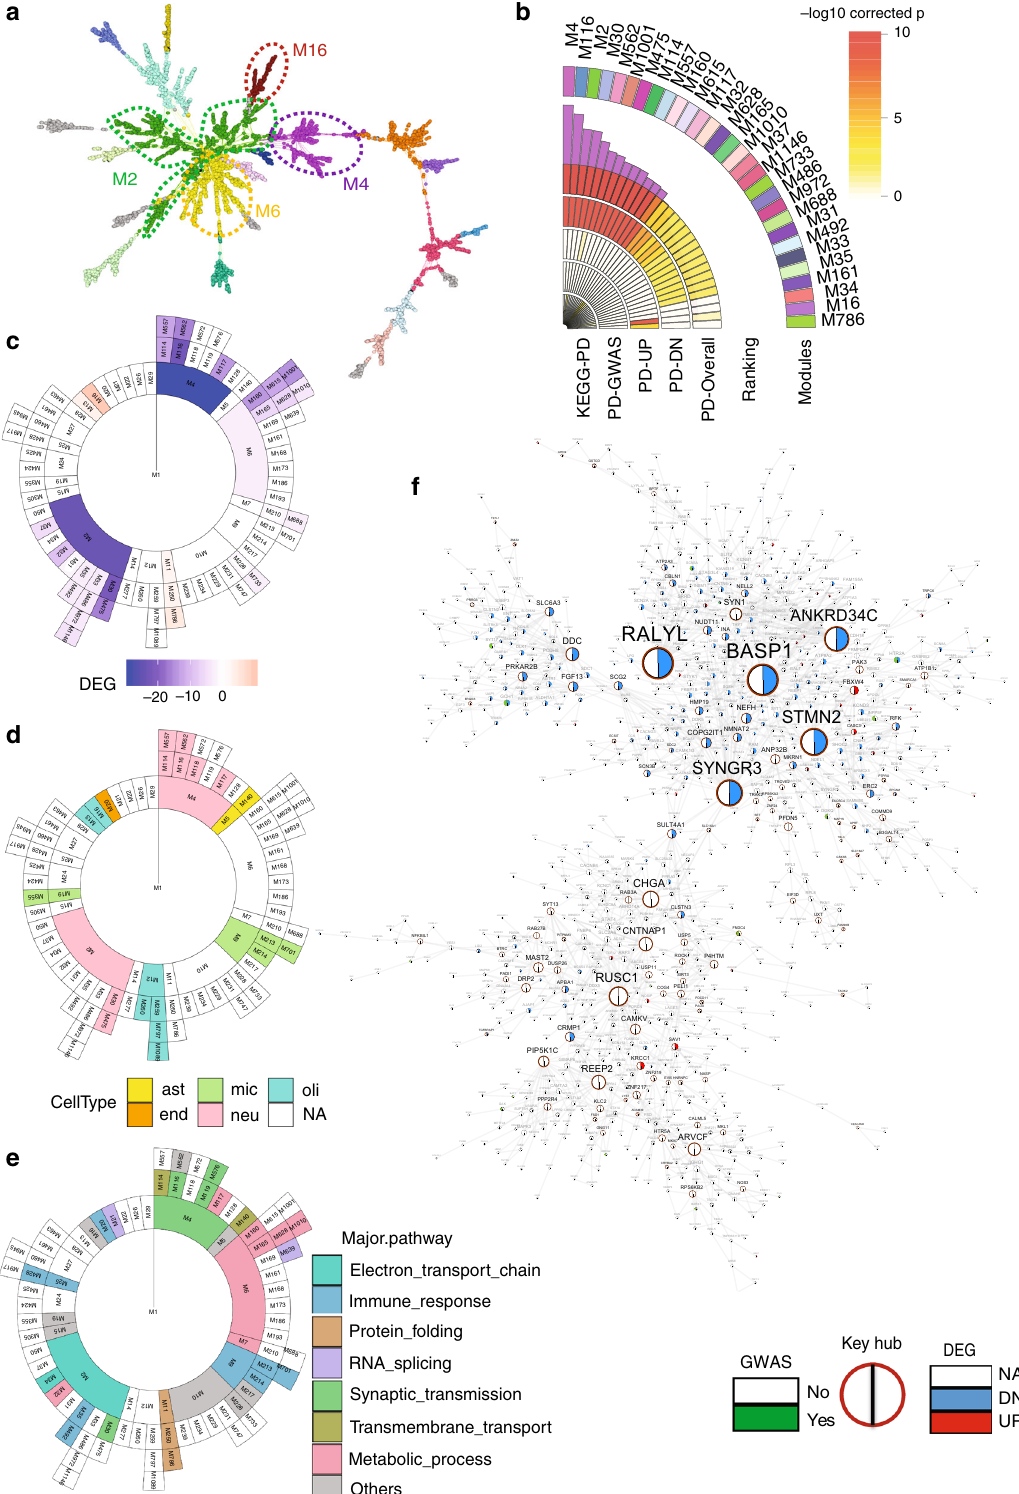
Fig. 1 Gene co-expression modules associated with PD. a A global MEGENA network. The modules at one particular compactness scale are represented by different colors. Four parental modules (M4, M2, M6, and M16) most associated with PD are highlighted. b The top 30 MEGENA modules most enriched for the PD-related gene signatures including the PD DEGs, the PD GWAS genes, and the genes in the KEGG PD pathway. c Enrichment of the DEGs of PD in all the MEGENA modules. Color intensity is proportional to − log10(corrected FET p -value). d Enrichment of cell-type-speci fi c gene signatures in all the MEGENA modules. Color intensity is proportional to − log10(corrected FET p -value). e Major pathways associated with the MEGENA modules. f The top-ranked module M4 is highly enriched for the downregulated DEGs in PD and the neuron-speci fi c gene signatures. Key regulators are highlighted in burgundy circles. The pie chart of each node indicates whether it is a DEG or GWAS gene. The size of a node is proportional to the node connectivity in the MEGENA